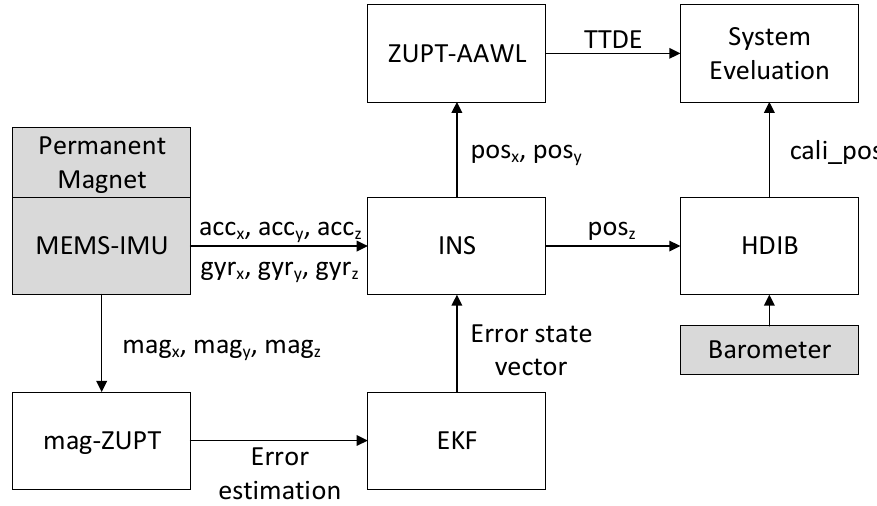
Figure 1. Structure of this novel 3D positioning system .